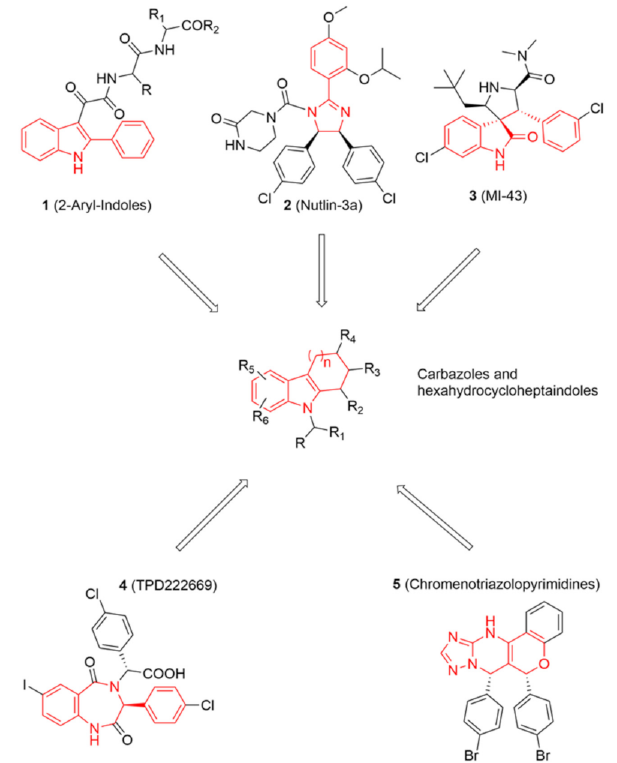
Figure 1. On the top and bottom of the chart, chemical structures of five known potent MDM2 inhibitors are shown. Chemical features shared among these inhibitors and some of database molecules, e.g., carbazoles (in the centre) are highlighted in red